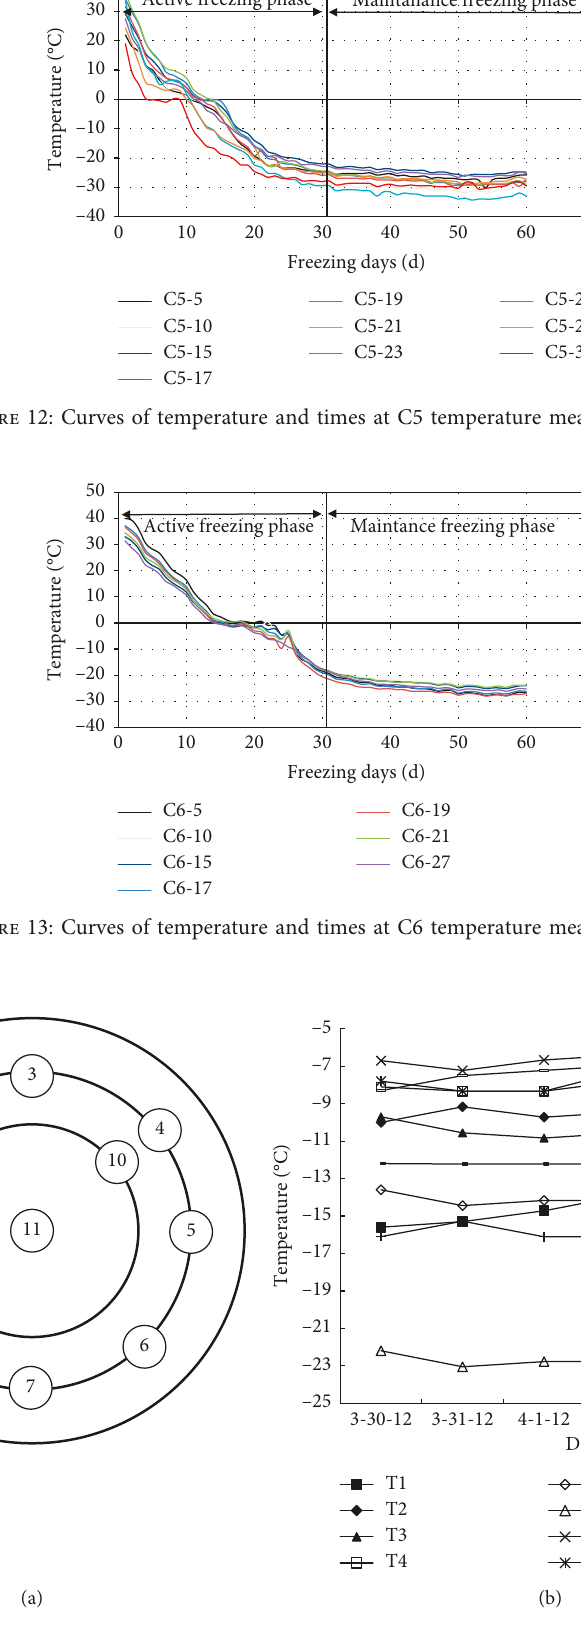
Figure 14: (a) Layout of measuring holes; (b) temperature of each measuring hole over